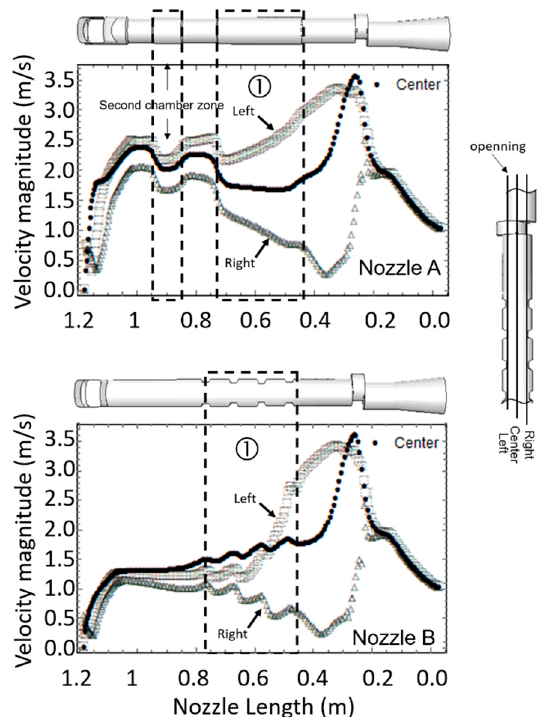
Figure 7. Velocity magnitude calculated at three lines along both nozzle lengths.